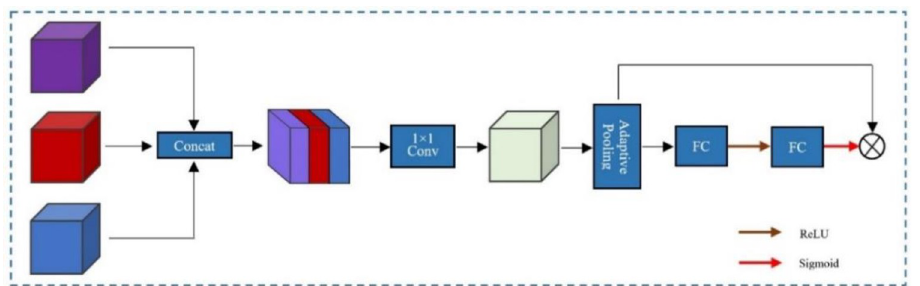
Fig 5. The feature aggregation module with channel